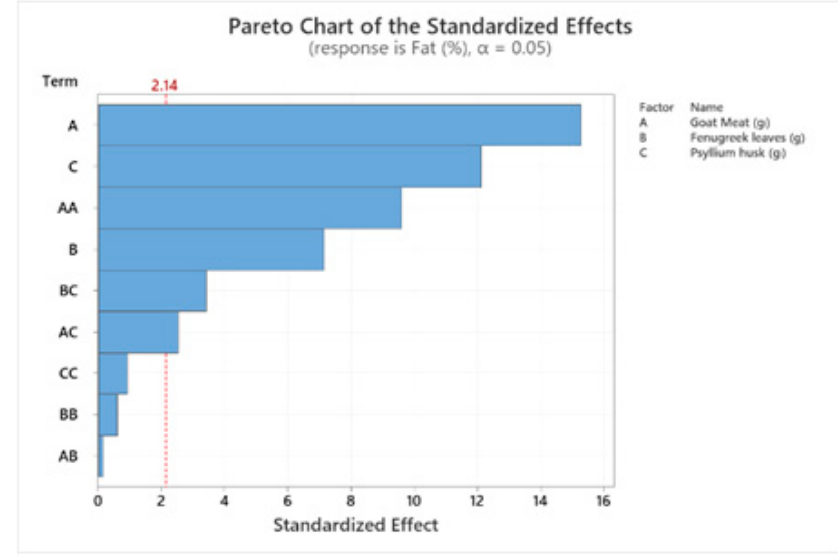
Figure 2. Pareto chart of standardized effects (linear terms: A, B, and C; quadratic terms: AA, BB, and CC; two-way interaction terms: AB, AC, and BC).